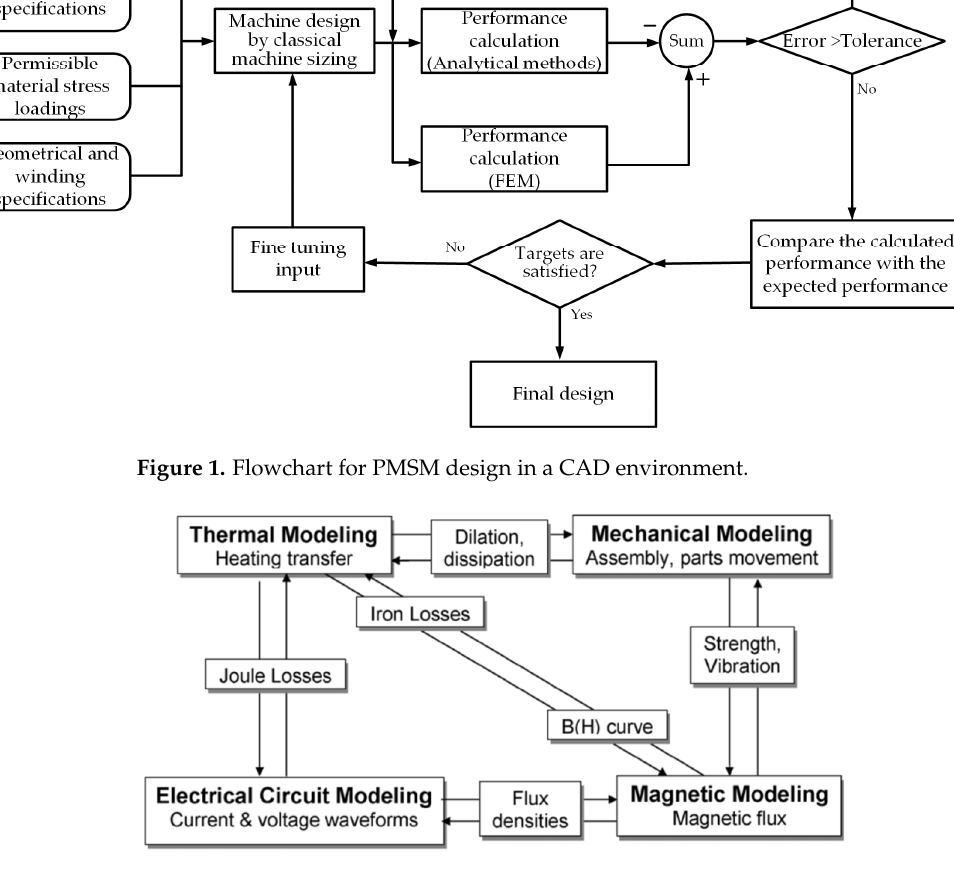
Figure 2. CAD environment with coupling of physical models [18].